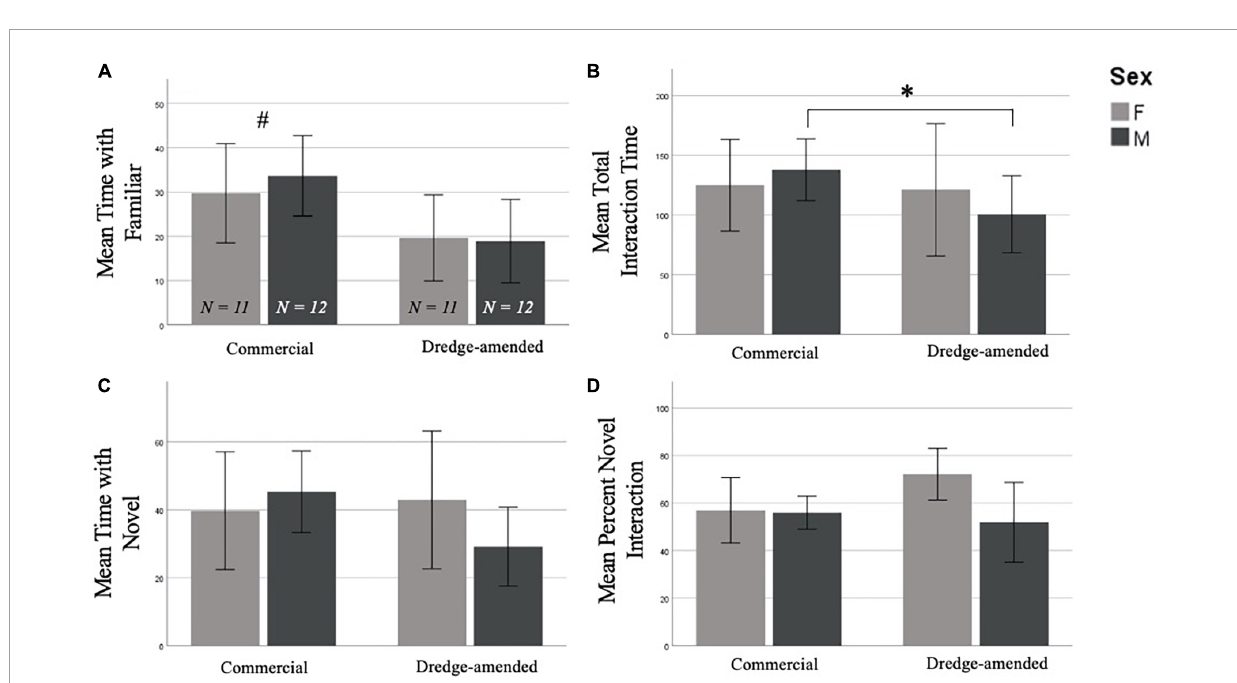
FIGURE2 Early exposure to dredge-amended corn affects adult Novel Object Recognition Test (Total N = 46; N = 12 males and 11 females per corn group). Mean time spent with the familiar object (A) , mean combined trial 1 and trial 2 object interaction time (B) , mean time spent with the novel object (C) , and mean percent novel interaction (D) , percent novel interaction (Amount of Time with Novel/Total Object Interaction Time) of the Novel Object Recognition Test with standard error bars. There was an effect of corn treatment (indicated by #) on interaction with the familiar object; additionally, and dredge-amended males spent significantly less time interacting with objects compared to commercial feed corn males (indicated by ∗ ). Time spent with the novel object and percent novel measurements did not result in significant differences between corn treatment or